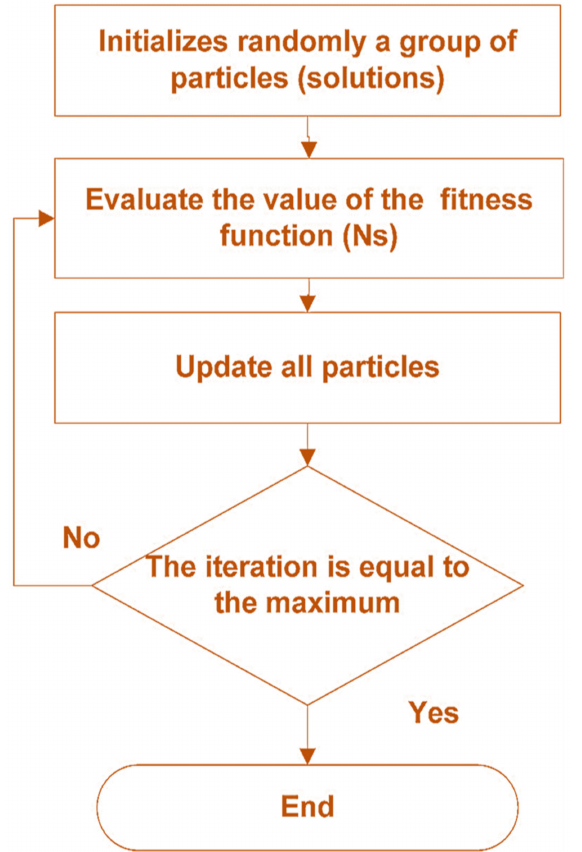
Figure 4. The implementation process of the particle swarm optimization